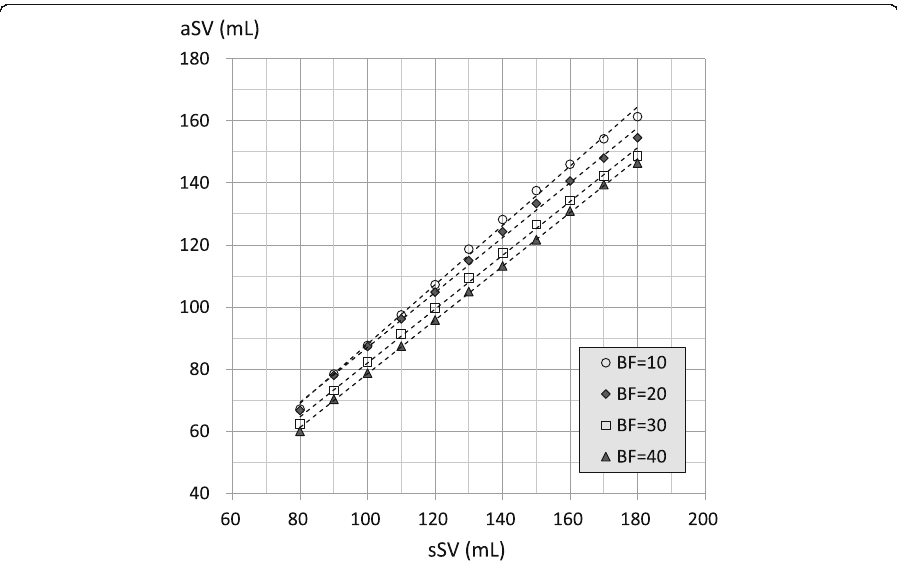
Fig. 2 Relationship between setting stroke volume (sSV) and actual stroke volume (aSV). Legend: Marker indicates the mean value of aSV ( n =5). Standard deviation is not indicated. The results of statistical significance test are as follows: BF=10 vs BF=20, ns with sSV=80 – 110, P <0.05 with sSV=120, P <0.01 with sSV=130 – 150, P